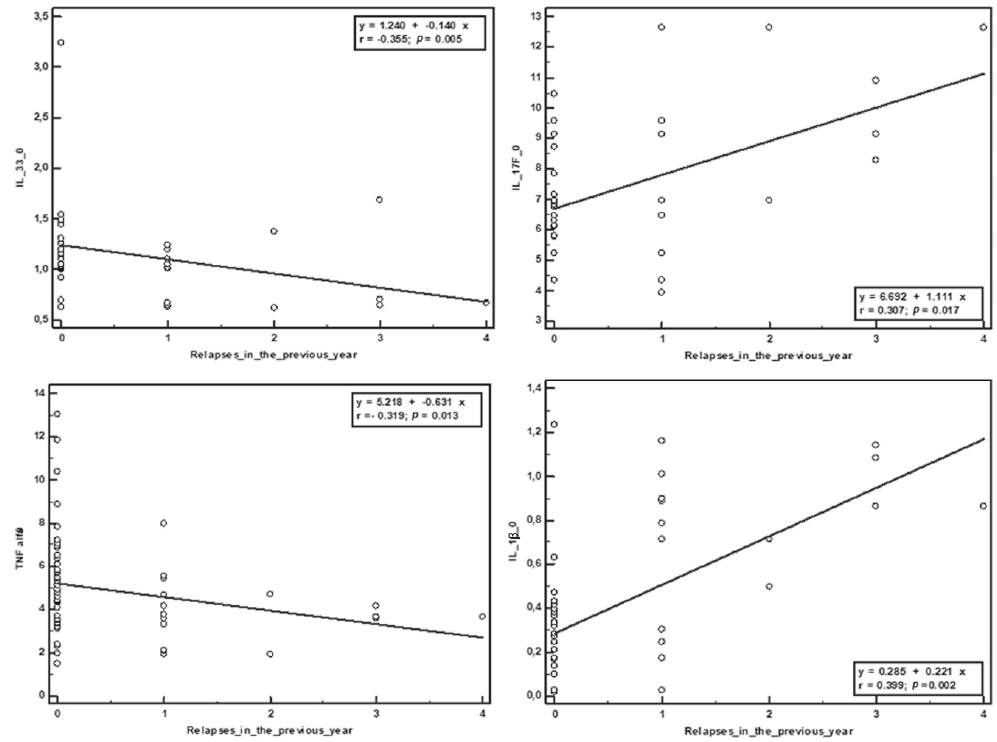
Figure 1. Correlations between the relapses in the year prior to the study and the initial serum cytokine levels.